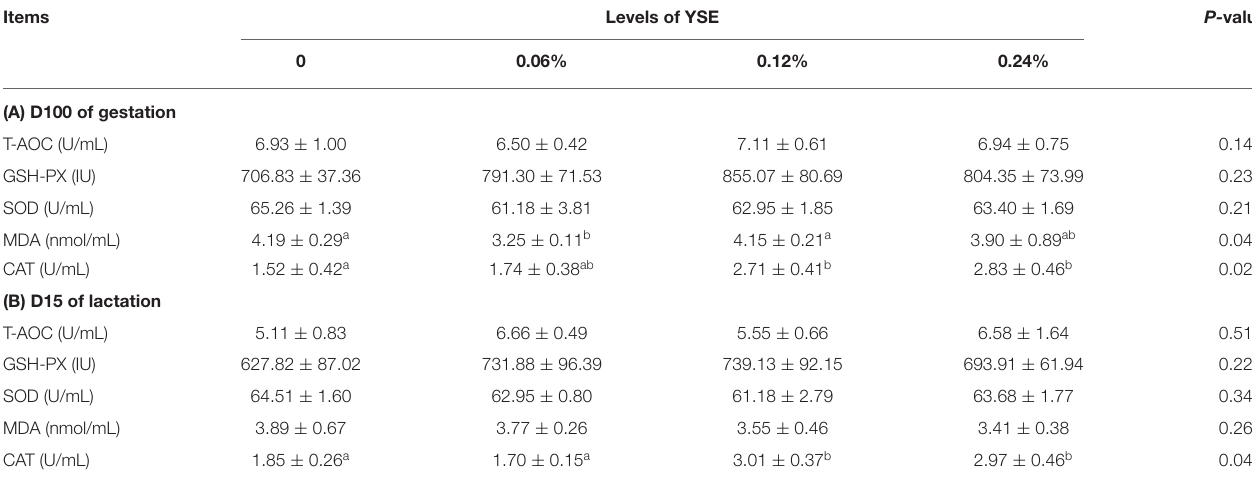
TABLE 7 | Effect of dietary YSE to blood antioxidative parameter in gestating and lactating sow. Items Levels of YSE P-